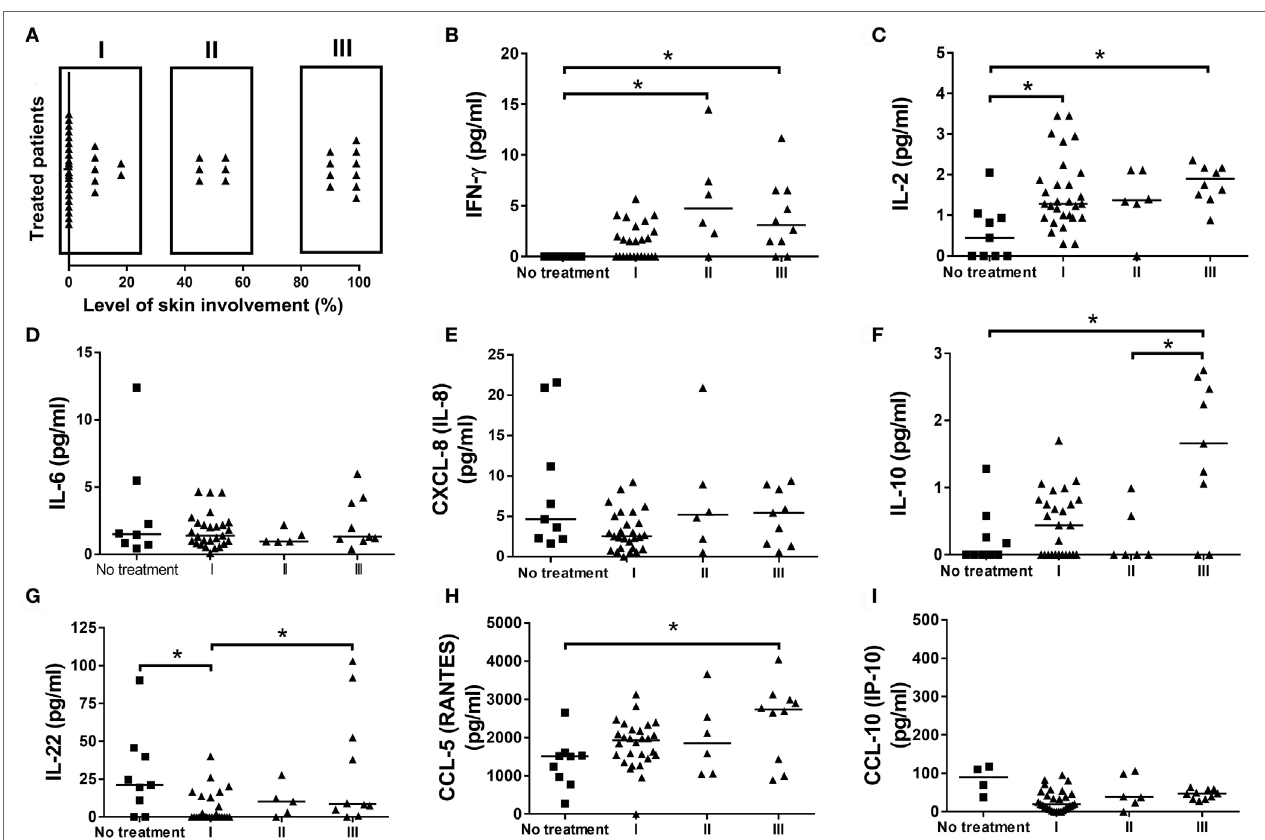
FigUre 3 | The profile of cytokines, chemokines, and disease severity in patients with the endemic form of pemphigus foliaceus. (a) Stratification of fogo selvagem (FS) patients according to the extension of skin lesions. Levels of (b) IFN- γ , (c) IL-2, (D) IL-6, (e) IL-8, (F) IL-10, (g) IL-22, (h) CCL-5/RANTES, and (i) CCL-10/ IP-10, from patients with the endemic form (FS) of pemphigus foliaceus without treatment (No treatment) compared to those taking immunosuppressive therapy with different degrees of lesions in skin (I-III). Lines represent median. * p < 0.05, Kruskal–Wallis test followed by Dunn’s